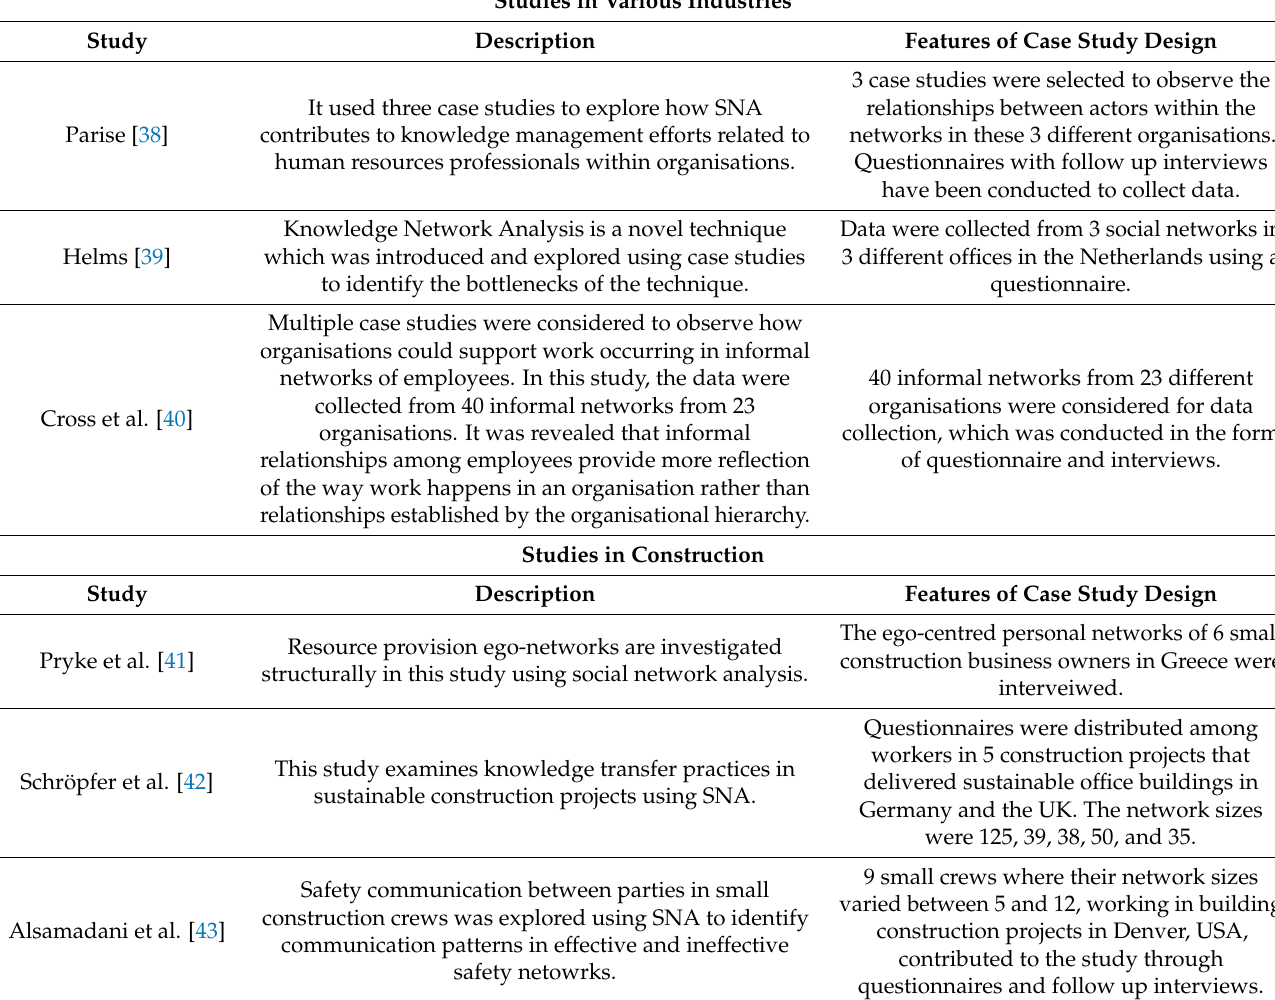
Table 2. Multiple case studies research